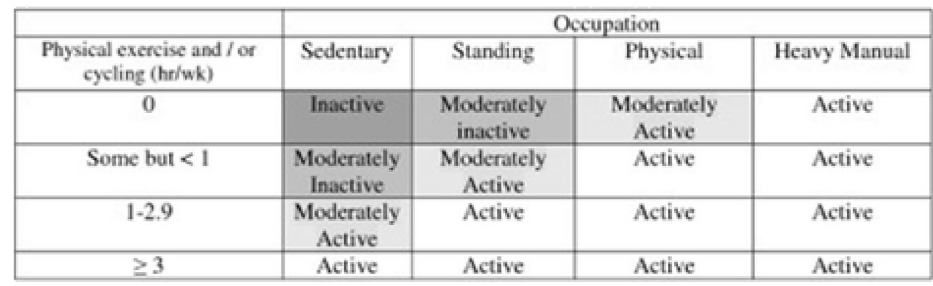
Figure 1. Summary of the GPPAQ Physical Activity Index